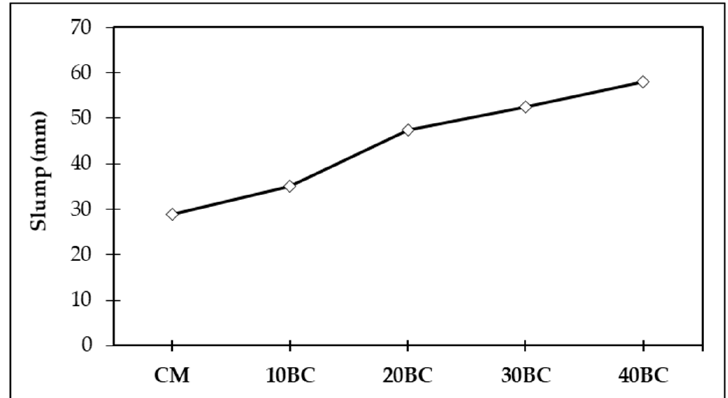
Figure 4. Comparison of slump values among several concrete mixes.